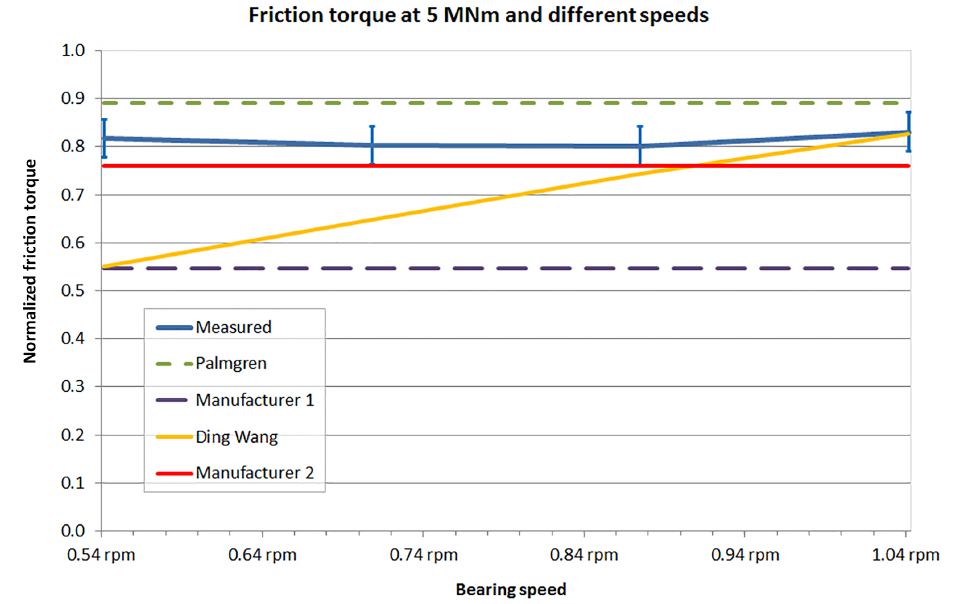
to achieve a match, the value had to be raised drastically com- pared to values for much smaller bearing diameters.